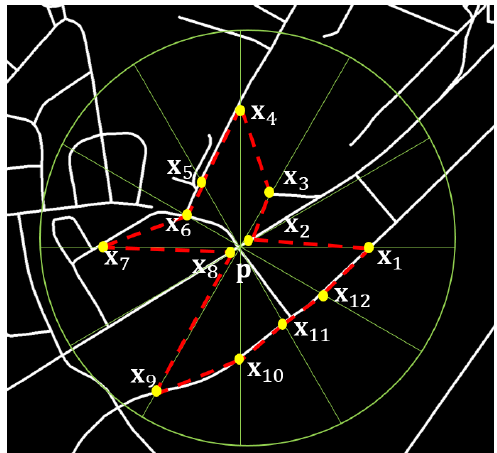
Figure 2. Definition of the Projective-Invariant Contour Feature (PICF). The contour of the point p consists of all neighbor points in each direction. In this figure, we draw 12 neighbor points x i , i = 1, . . . ,12 on the contour of p in yellow and connect these points into a polyline in red. When more neighbor points are added, the polyline can approximate the contour of p better. The PICF encodes the relative positions of points around p